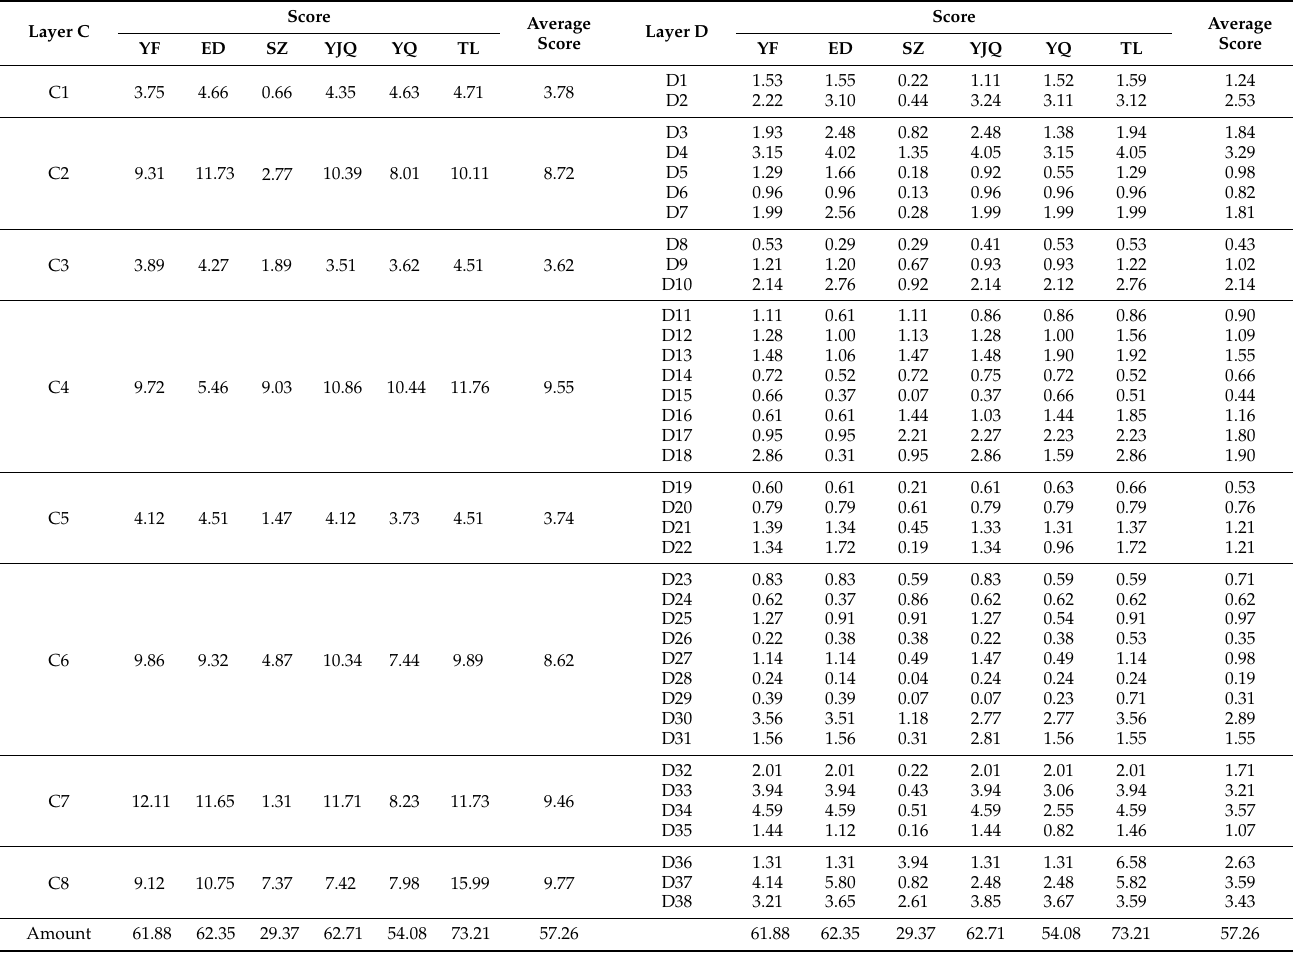
Table 3. Comprehensive evaluation index